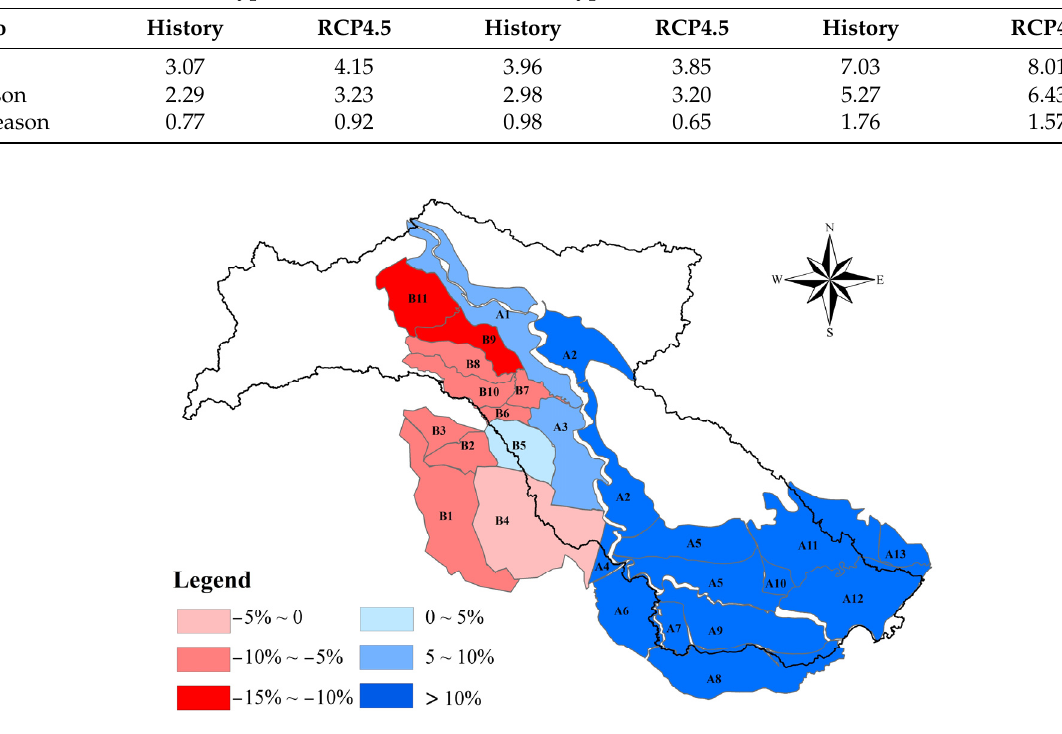
Figure 5. The percentage changes of available water resources under RCP4.5 scenario to the historical scenario in every operational zone (the blue indicates the increase while the red indicates the decrease).